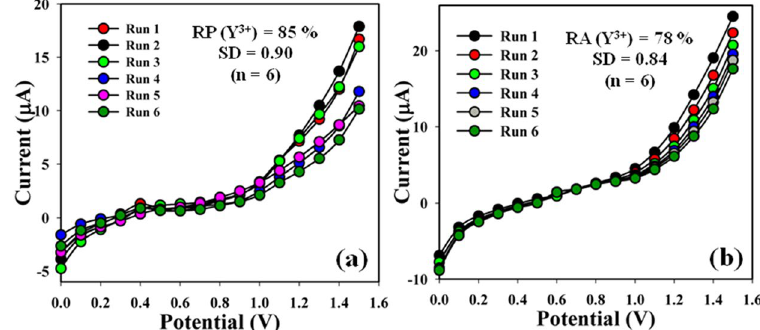
Figure 9. ( a ) Reproducible and ( b ) Repeatability study of 2-MNBBSH/GCE sensor.